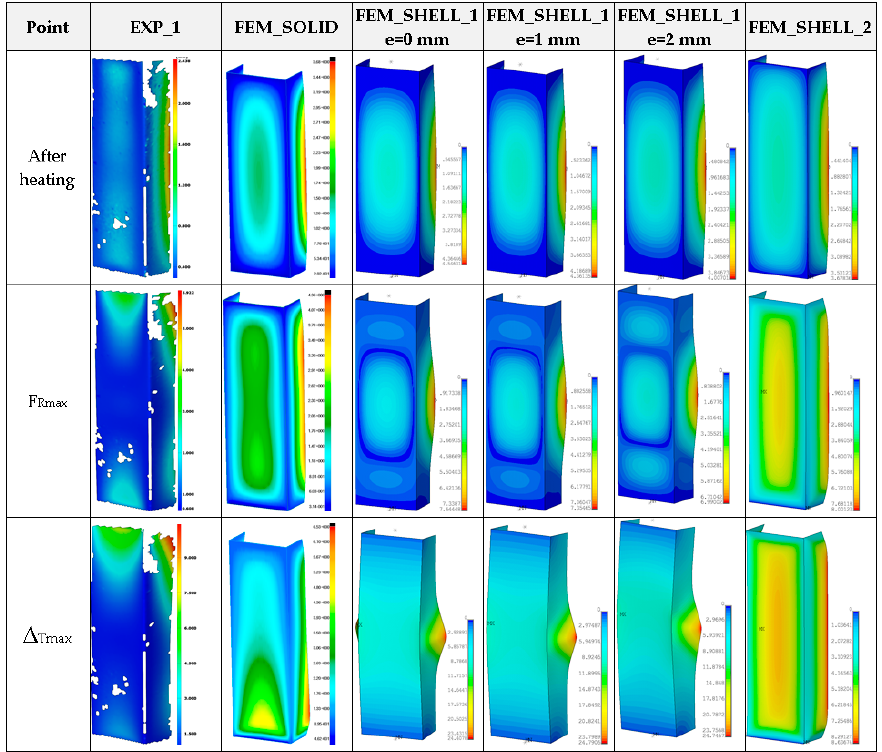
Figure 15. Deformation maps of columns at 75 °C.